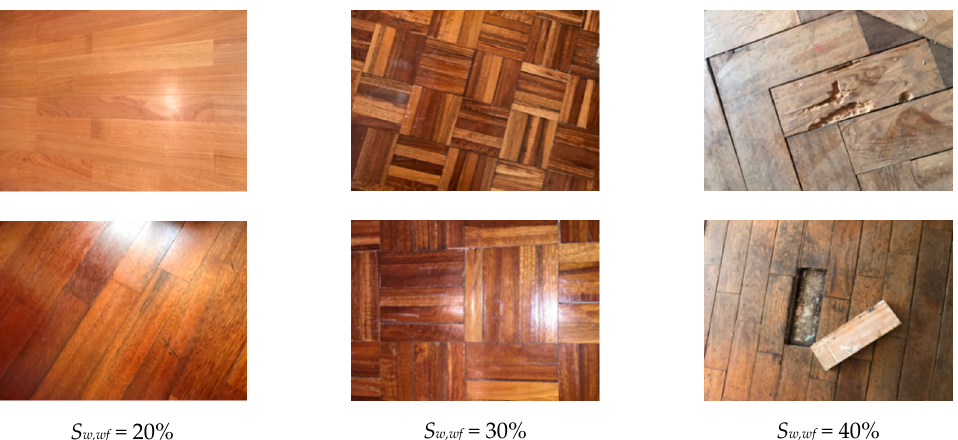
Figure 3. Illustrative examples of the overall condition of the wood floorings for different levels of the severity of degradation index.